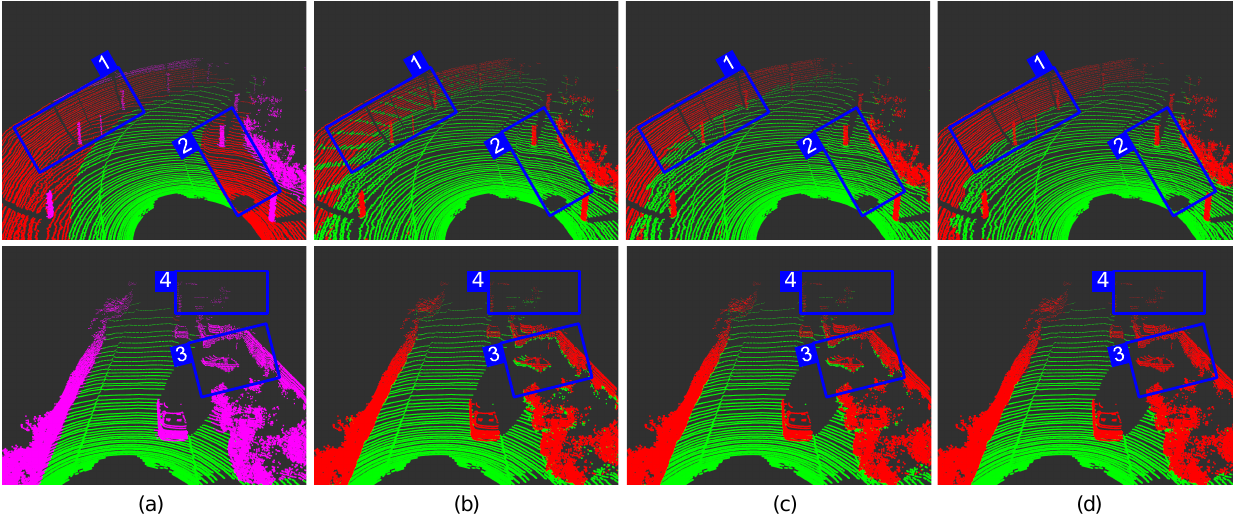
Figure 9. Segmentation result of each module in different scenes. Grounp 1 is the ordinary road scene; Grounp 2 is the residential road scene. ( a ) Benchmark; ( b ) REM; ( c ) RECM; ( d ) RECM +